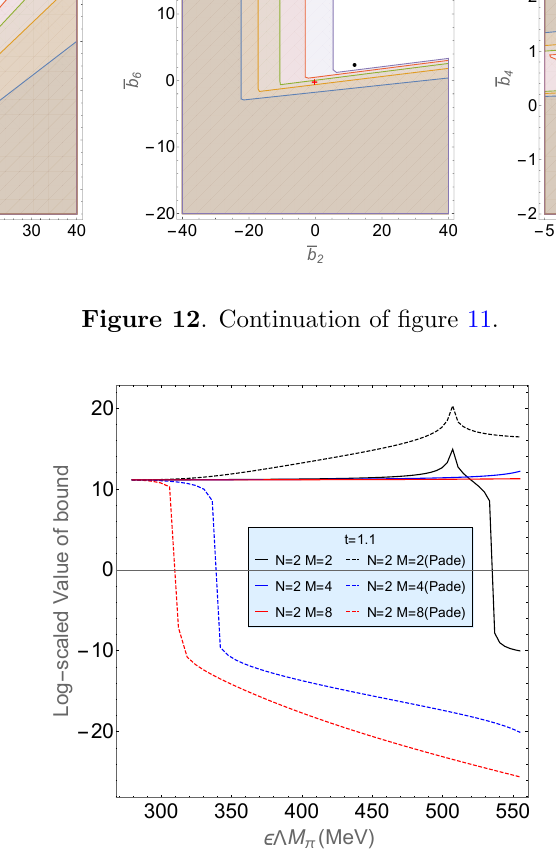
Figure 13 . Comparison of the improved Y bounds with (solid lines) and without (dashed lines) the Pad(cid:19)e approximation. The example is for the (cid:25) 0 (cid:25) 0 ! (cid:25) 0 (cid:25) 0 scattering amplitude up to two loops. The longitudinal axis indicates the logarithmically scaled values of the